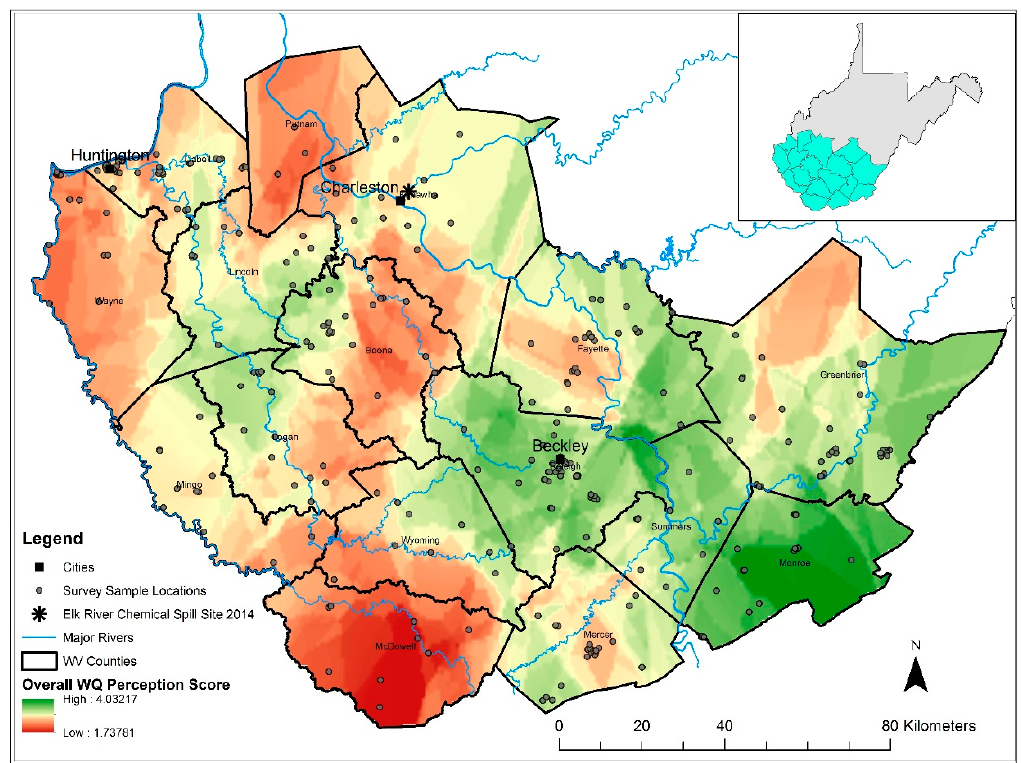
Figure 2. Kriging interpolated prediction surface using exponential semivariance model to predict overall water quality perception scores across study area in Southern West Virginia. Values range from 1 (lowest water quality perception; red) to 5 (highest water quality perception; green).